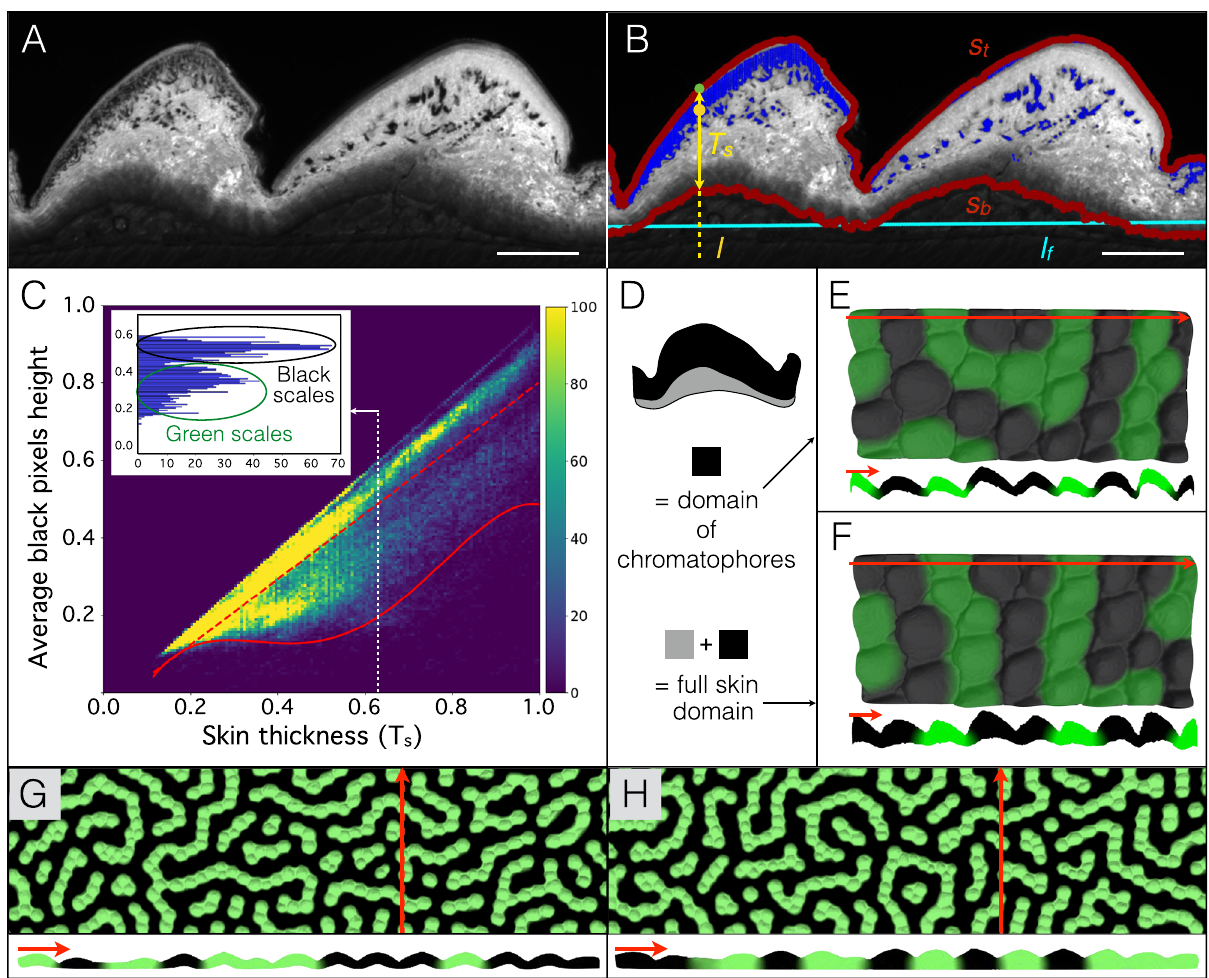
Fig. 3 Actual skin geometry generates a discretised pattern in ocellated lizards. A HREM section in a black scale (left) and a green scale (right). Scale bar = 200 µ m. B Automated detection of top ( S t ) and bottom ( S b ) skin surfaces (red) and of black pixels (marked in blue) corresponding to melanin in melanophores. Cyan line = linear fi t ( l f ) to S b . For each point on the top surface (e.g., green spot), skin thickness (yellow double-headed arrow, T s ) and average height (yellow spot) among all black pixels falling on the line l perpendicular to l f were computed. C Black pixel height versus skin thickness in HREM sections from four black and four green skin scales (>250,000 data points, 150 bins in each direction). Red dashed line = linear fi t to average pigment height. Plain red line = fourth-order polynomial fi t to lower bound of 3-STD interval around the average pigment position. Inset: histogram for T s = 0.63 revealing two peaks corresponding to black and green scales. Height and thickness are normalised by the maximum observed value. D Diagram of a skin scale with full skin and chromatophore-restricted domains indicated. E , F 3D numerical simulations in the domain restricted to melanophore ( E ) or in the full skin ( F ) both generate a scale-by-scale steady-state colour pattern. Red lines indicate positions of the corresponding sections. G , H 3D numerical simulations in extended network of scales; surface geometry was inferred by shape-from-shading scanning of a large patch of lizard skin whereas chromotophore-restricted 3D domain ( G ) or full skin domain ( H ) was generated by applying statistics from HREM